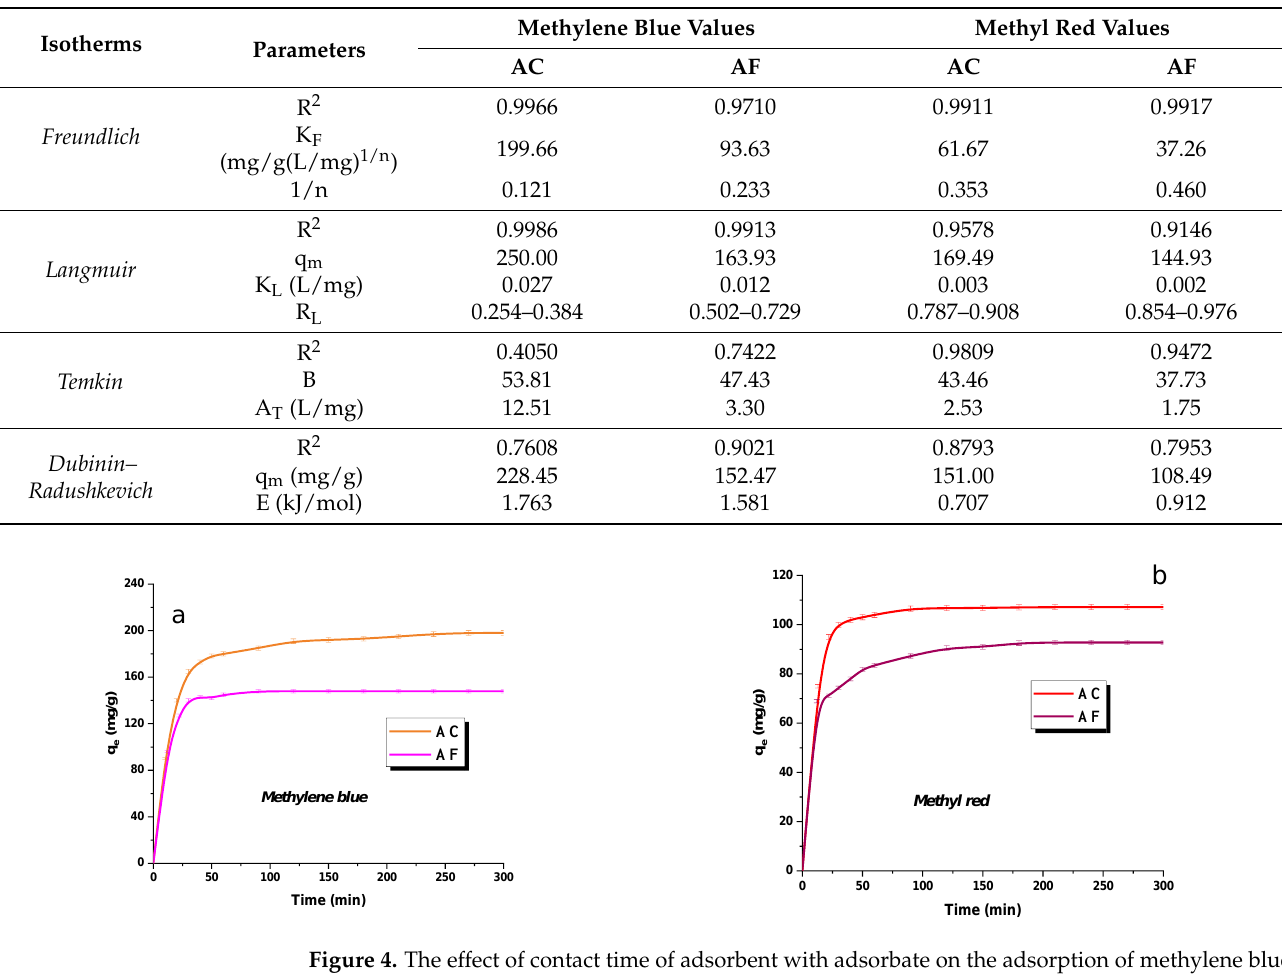
Table 5. The isotherm adsorption parameters of methylene blue and methyl red.